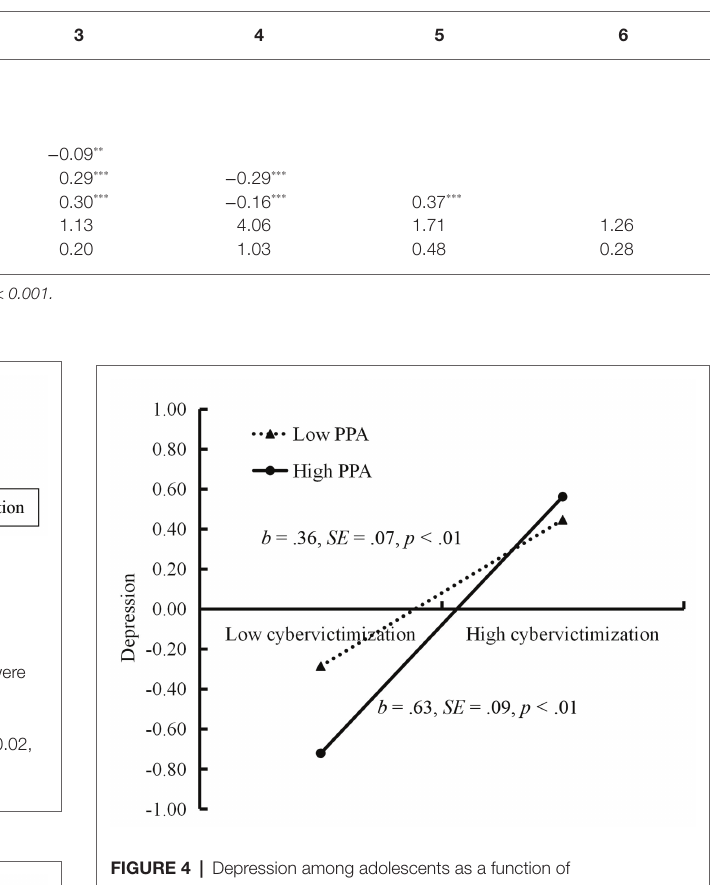
TABLE 1 | Descriptive statistics and correlations for all variables.